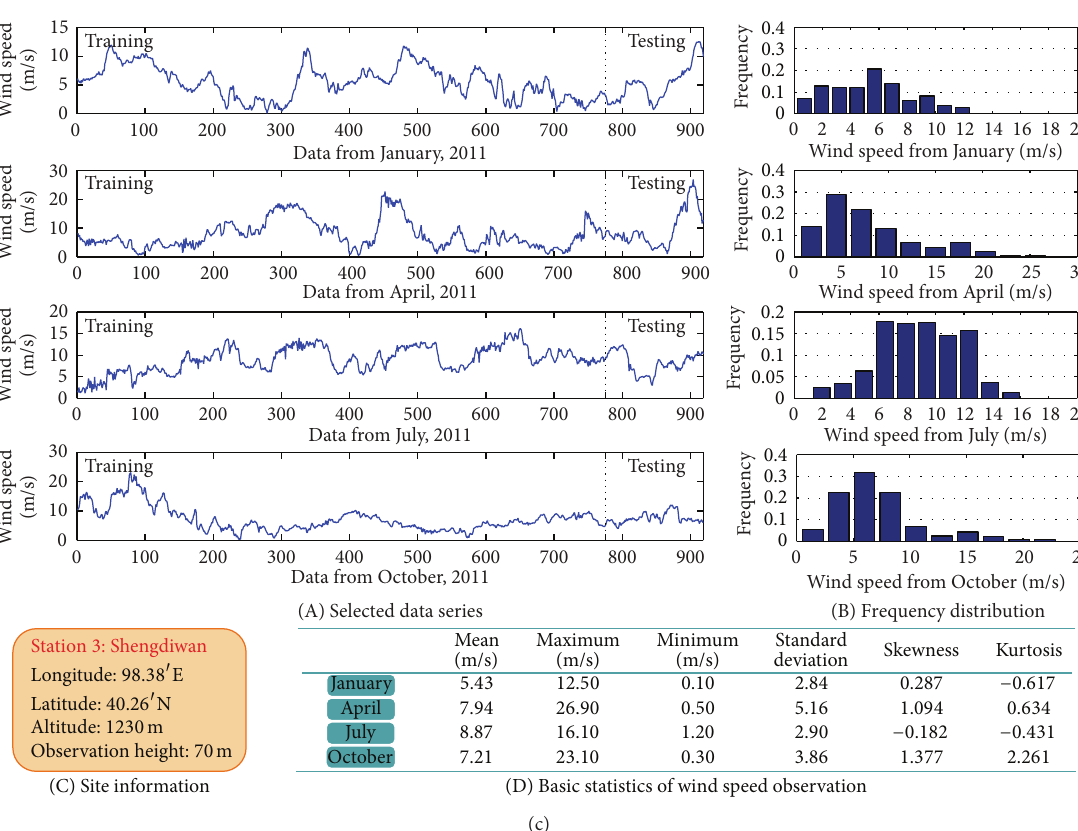
Figure 3: (a) Selected datasets from Station 1: Tianshuijing. (b) Selected datasets from Station 2: Qiaowan. (c) Selected datasets from Station 3: